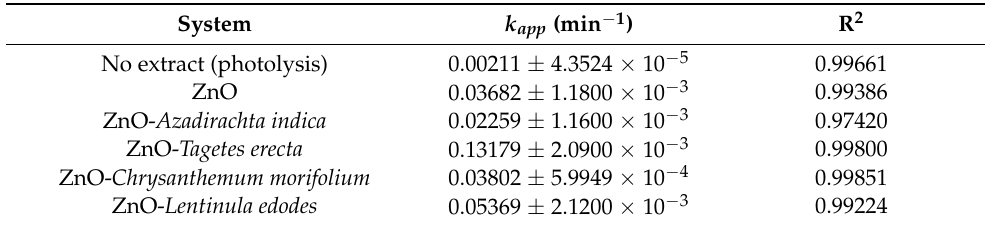
Table 4. Apparent rate constant for the photocatalytic degradation of MB dye with ZnO NPs synthesized with different botanical